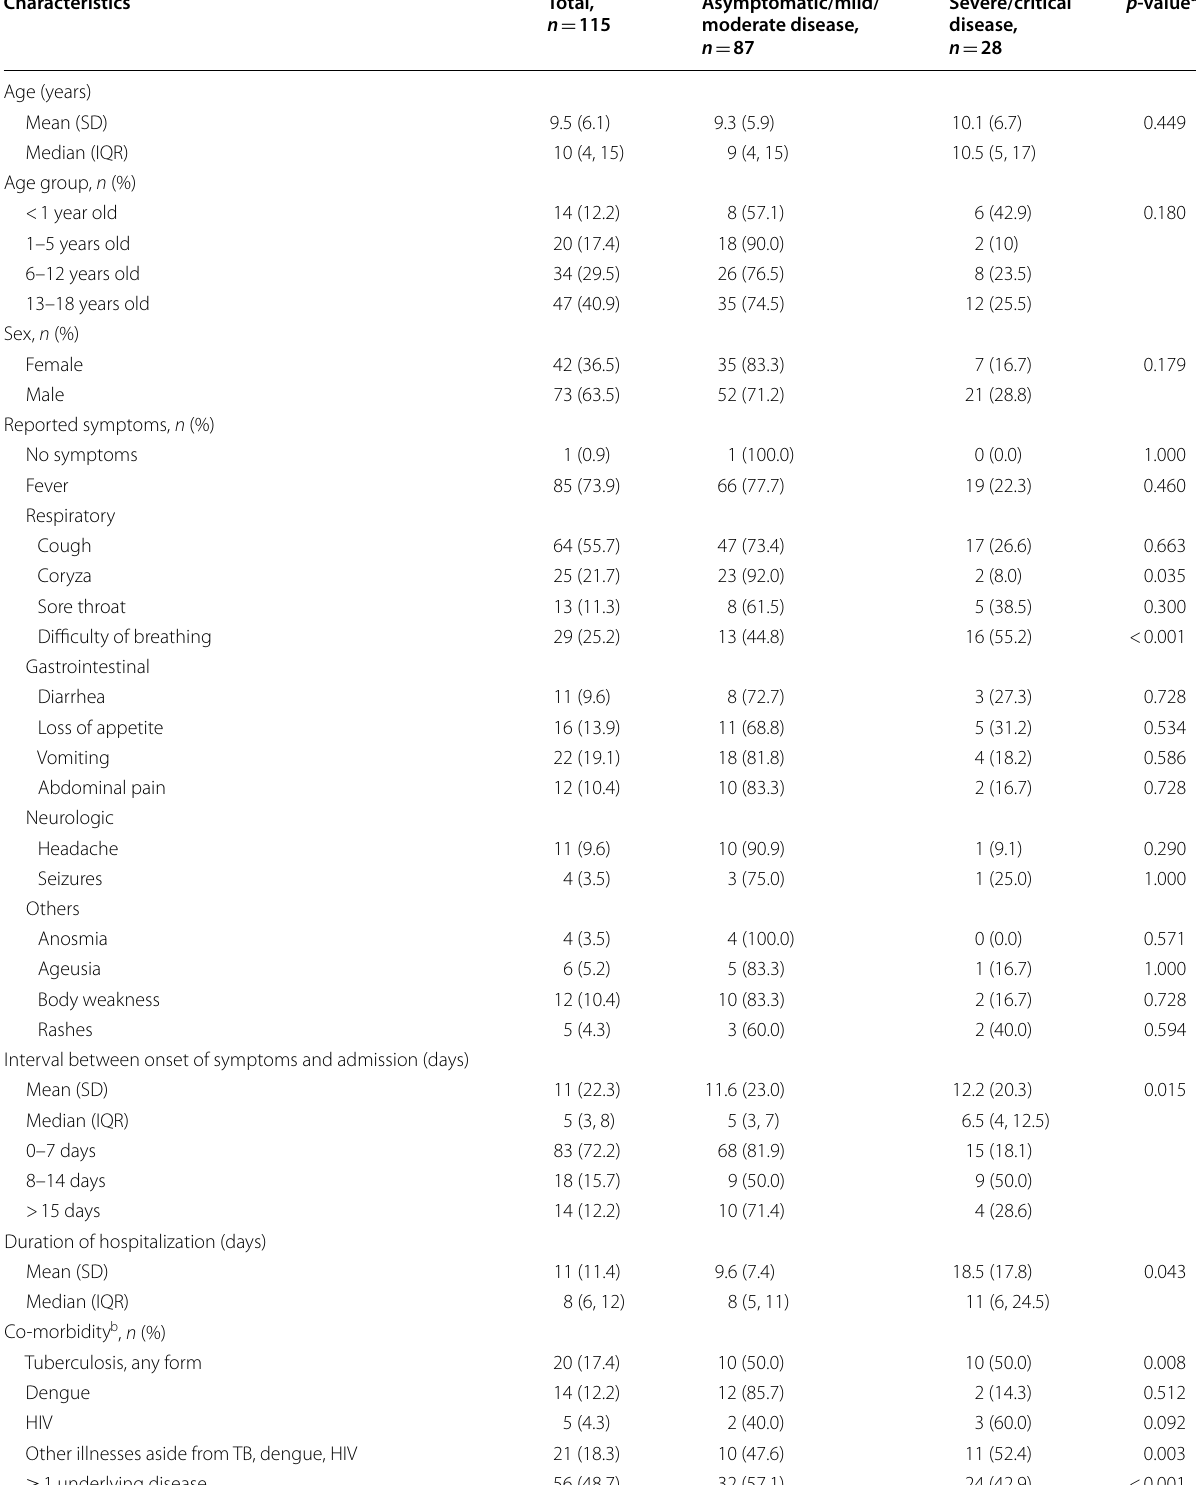
Table 1 Epidemiologic and clinical features of children with COVID‑19 admitted to San Lazaro Hospital, January 25, 2020 to January 25, 2022 ( n =